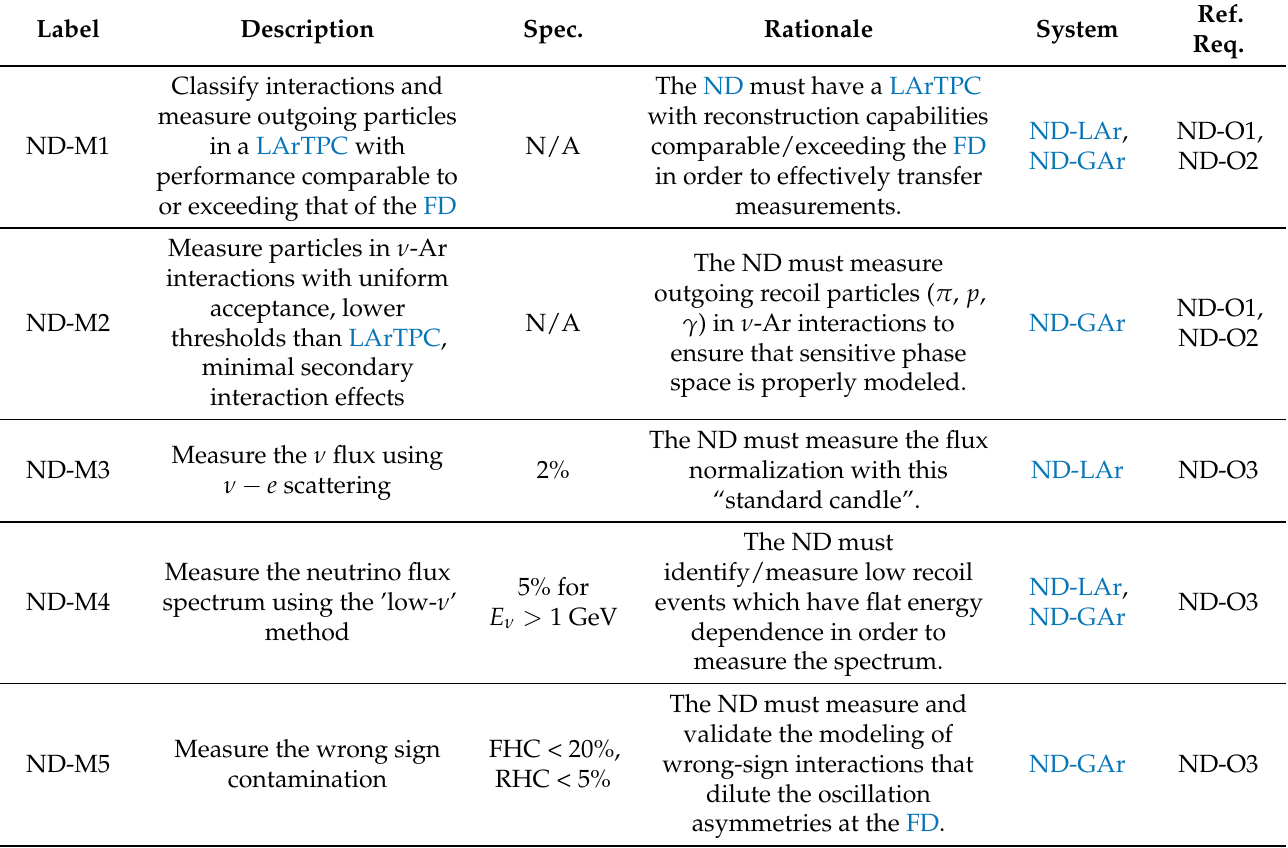
Table 3. Measurement requirements for